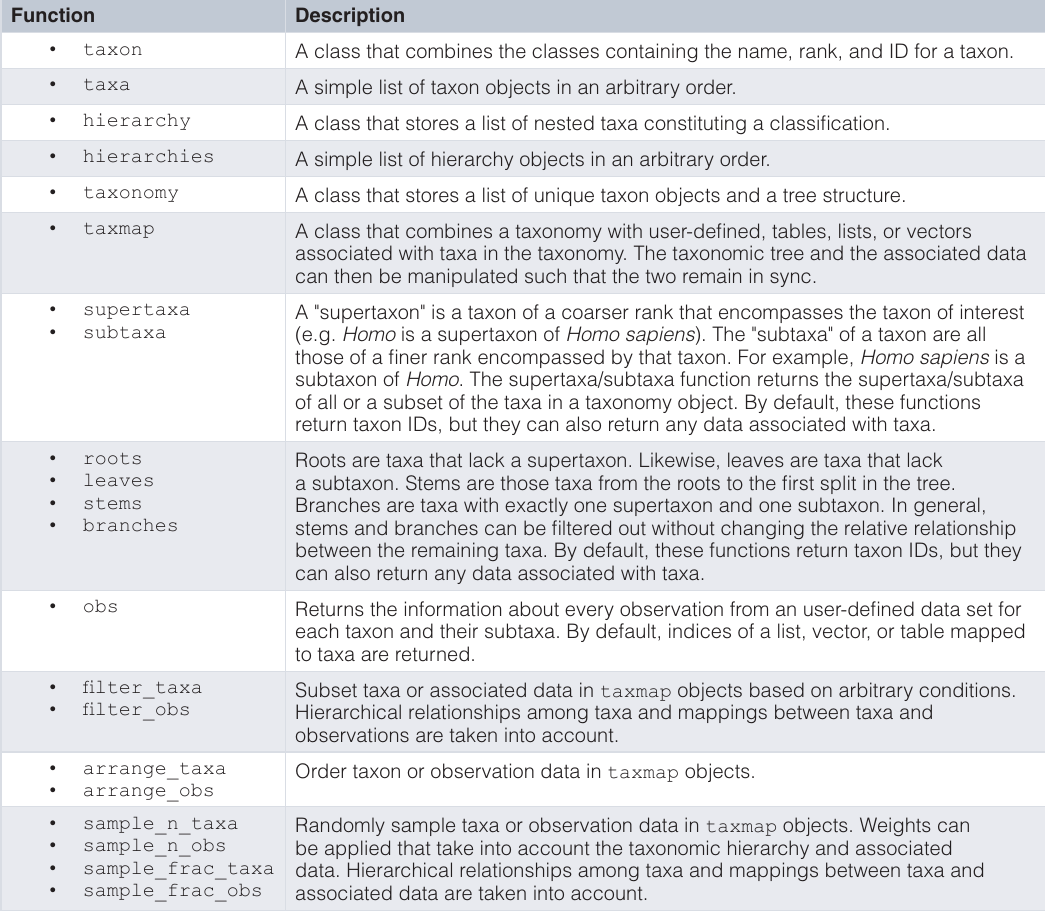
Table 1. Primary classes and functions found in taxa . Function